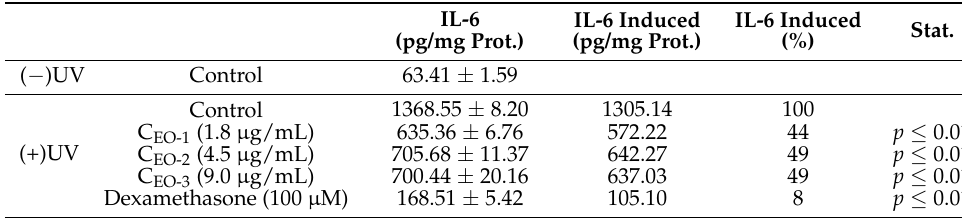
Table 7. Determination of IL-6 contents.